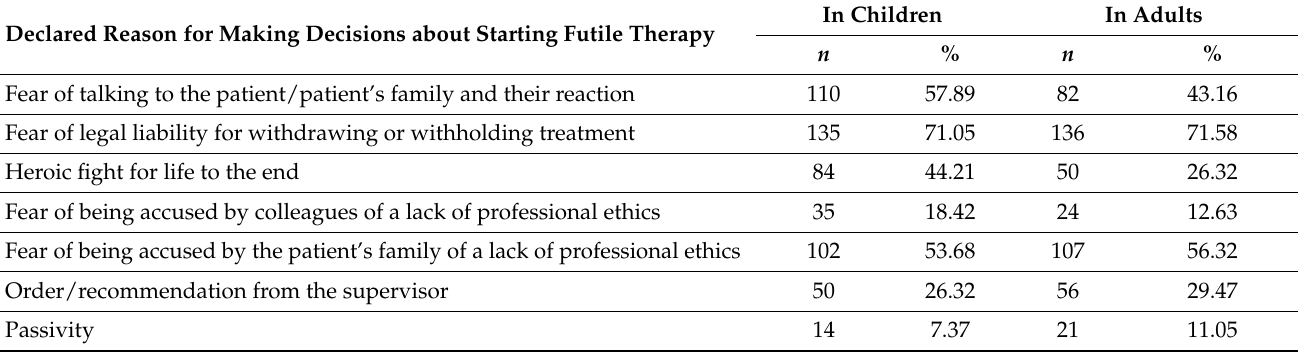
Table 3. Reasons for starting futile therapy in the population of paediatric and adult